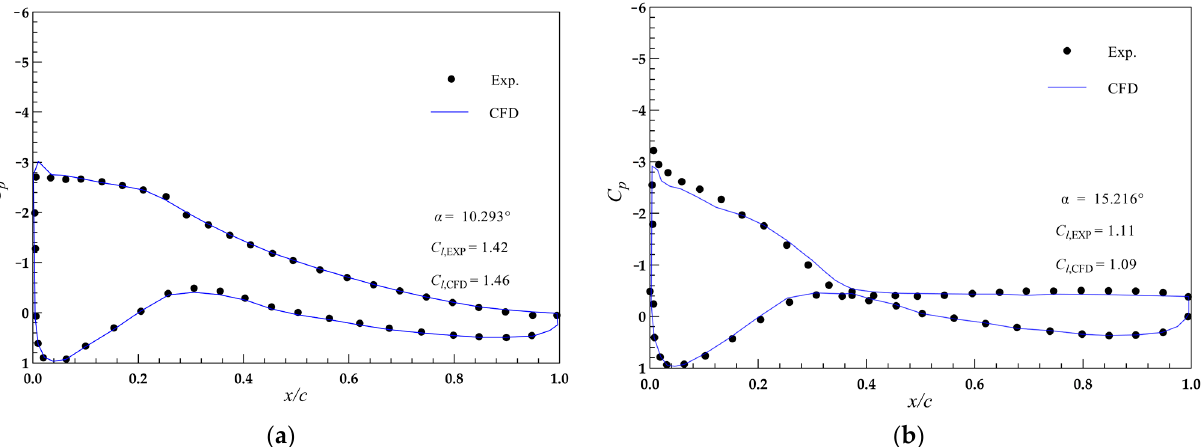
Figure 13. Comparison of airfoil performance between experimental and simulation ( a ) α = 10 ° ; ( b ) α = 15 ° .